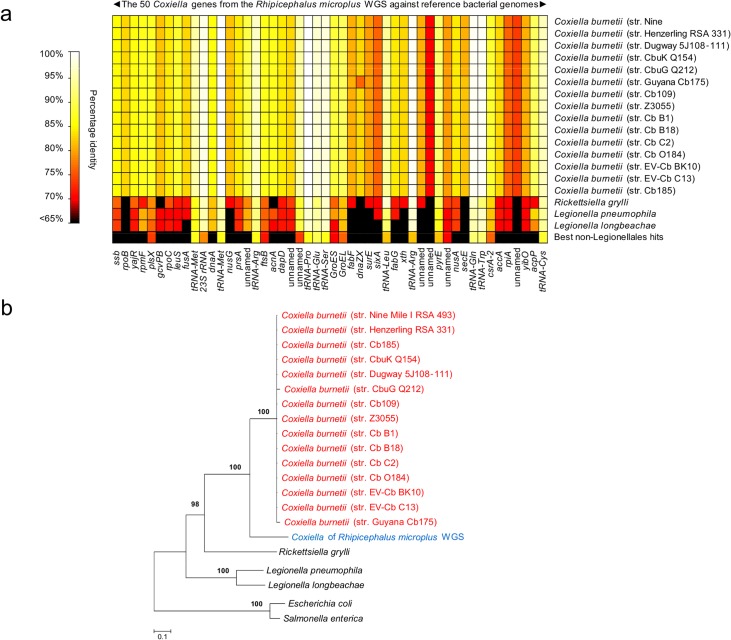
Characterization of new Coxiella strains derived from whole-genome sequencing (WGS) of the cattle tick Rhipicephalus microplus.(a) Percent identity of 50 genes uniquely attributable to Coxiella from R. microplus WGS versus 15 sequenced C. burnetii genomes and other reference genomes. (b) Bacterial phylogeny, comprising the Coxiella found in the R. microplus WGS data, reconstructed from the concatenated sequences of Fig 3A (19,304 unambiguously aligned bp) using maximum-likelihood (ML). Branch numbers indicate percent bootstrap support for major branches (1,000 replicates; only bootstrap values >90% are shown). The scale bar is in units of substitution/site.